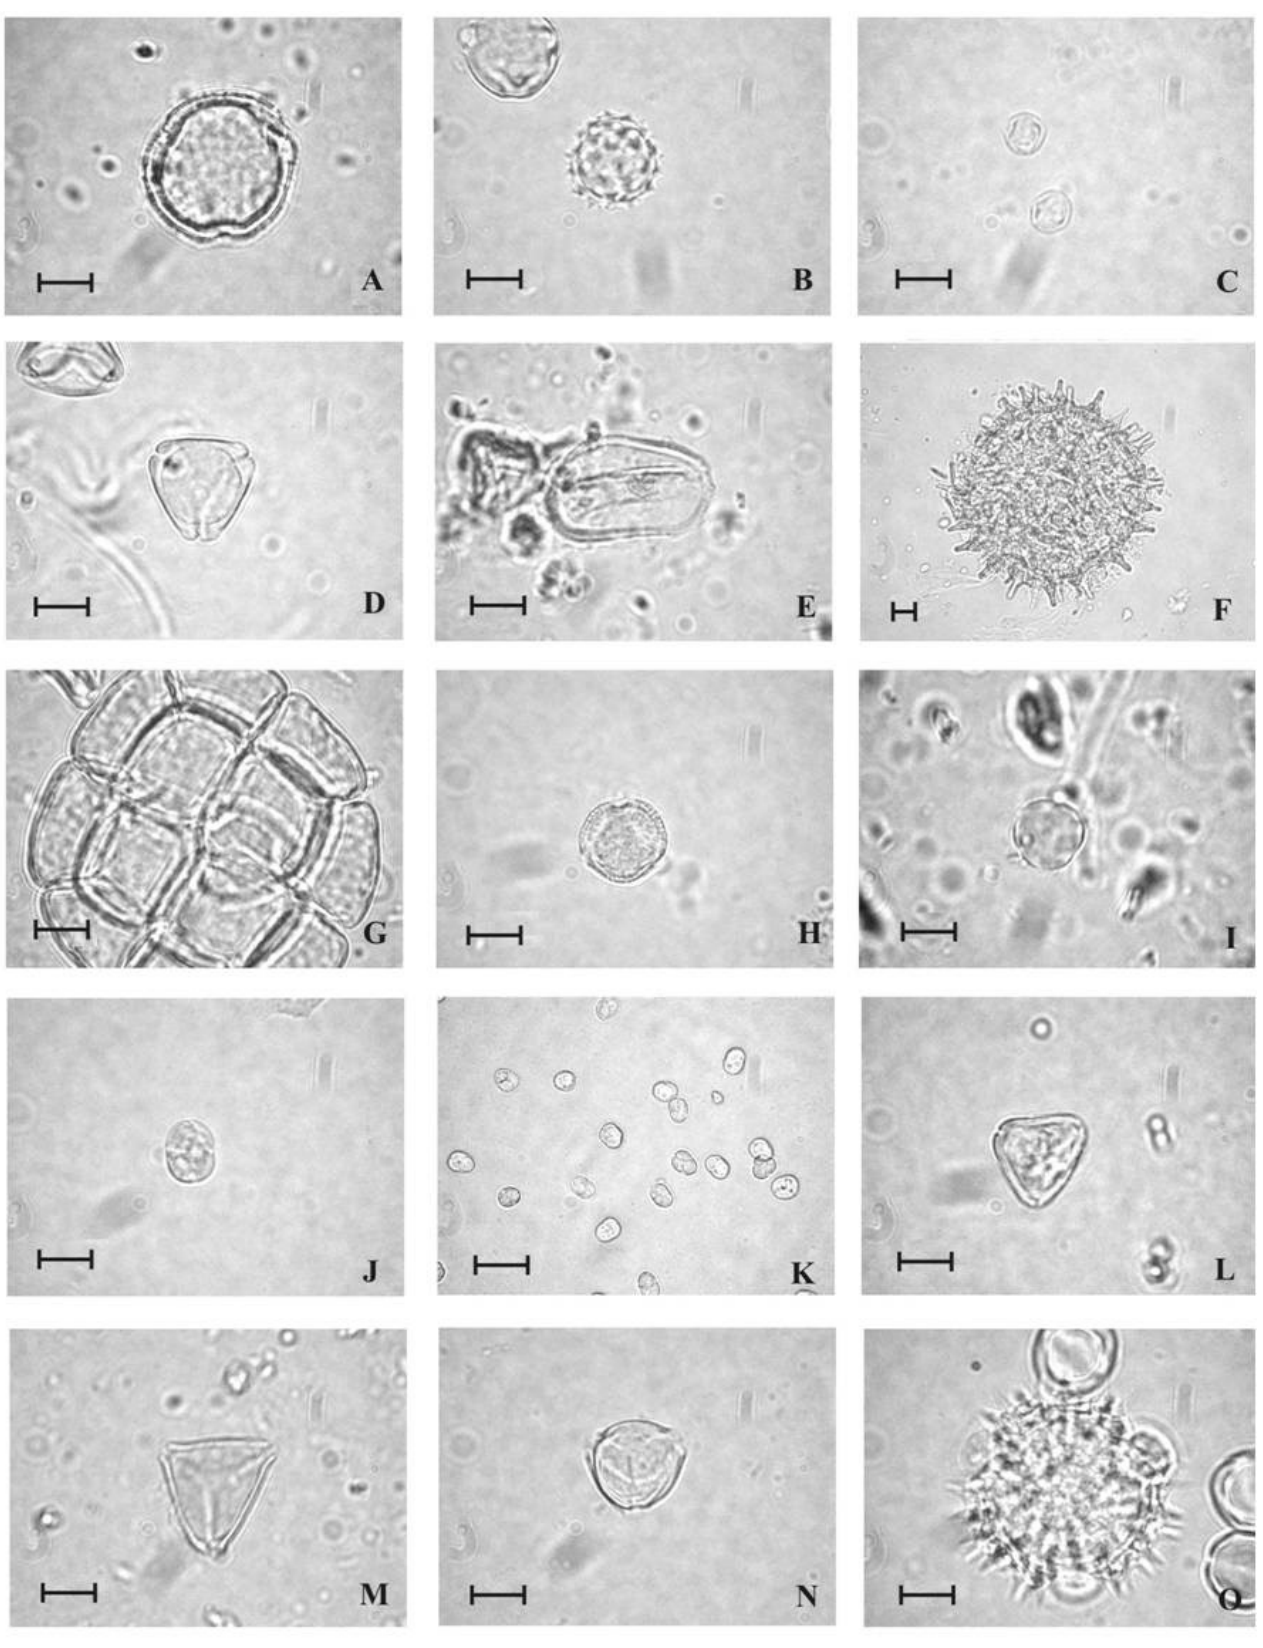
Fig 5 . Light microscopic (LM) pollen grain types micrographs observed in both honey and pollen pellets samples of Melipona quadrifasciata in Parque das Neblinas, Mogi das Cruzes district, São Paulo, Brazil. Figure A. Aegiphila . B. Baccharis . C. Begonia . D. Eucalyptus . E. Euterpe/Syagrus . F. Hibiscus . G. Inga . H. Machaerium . I. Melastomataceae. J. Mimosa caesalpiniaefolia . K . Mimosa scabrella . L. Myrcia . M. Serjania . N. Solanaceae. O. Vernonia . Scales =